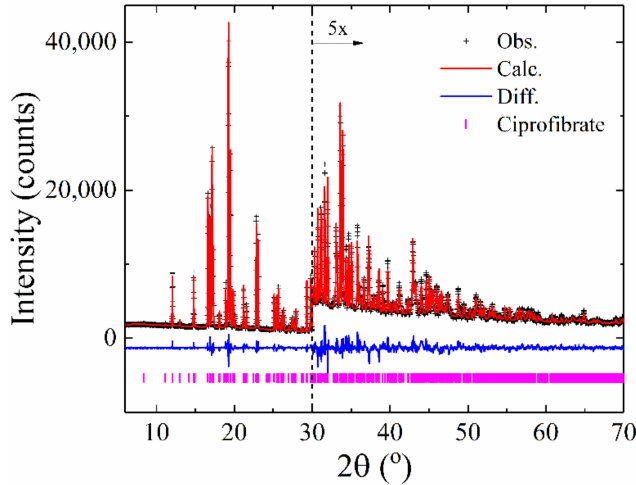
Figure 3. Rietveld plot for CIP showing the excellent agreement between the experimental data (black crosses) and the calculated profile (red line). The blue line displays the difference between observed and calculated data. The magenta vertical bars at the bottom represent the Bragg peaks’ positions. The region from 30 to 70 ◦ in 2 θ is magnified 5 times to clarify the good agreement between observed and calculated data in higher angles.